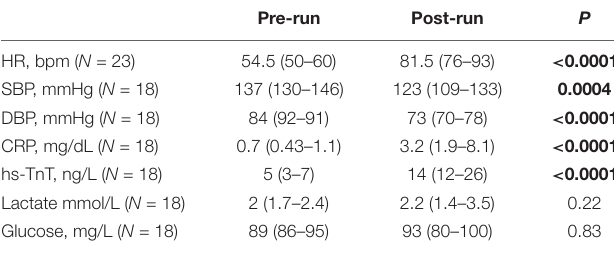
TABLE 2 | Pre- and post-run values of the analyzed parameters.